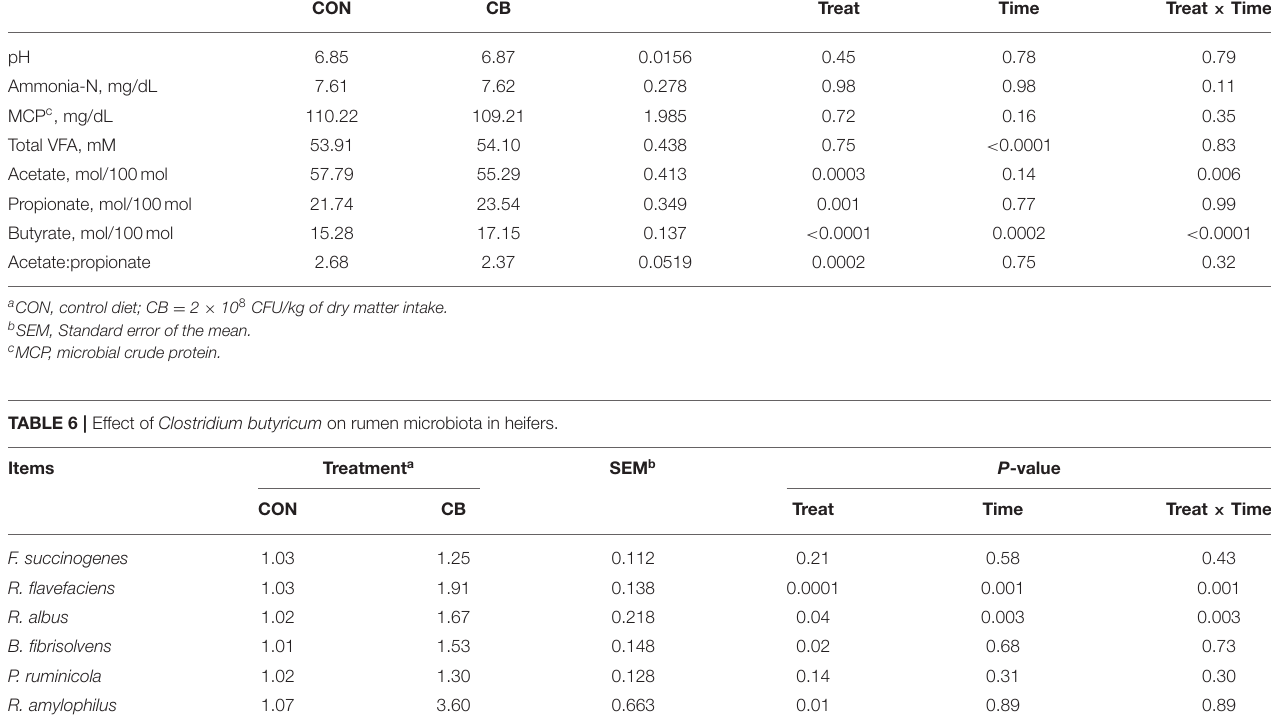
Table 6 . The C. butyricum had no effect on the relative abundance of F. succinogenes and P. ruminicola in the CB group. And C. butyricum significantly increased the relative abundance of